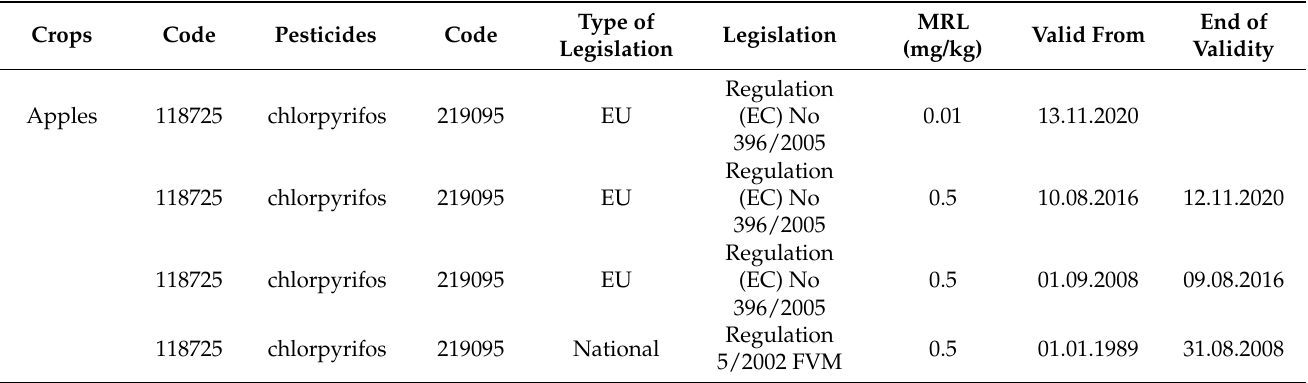
Table 4. Example for the MRLs included in the code dictionary of the central